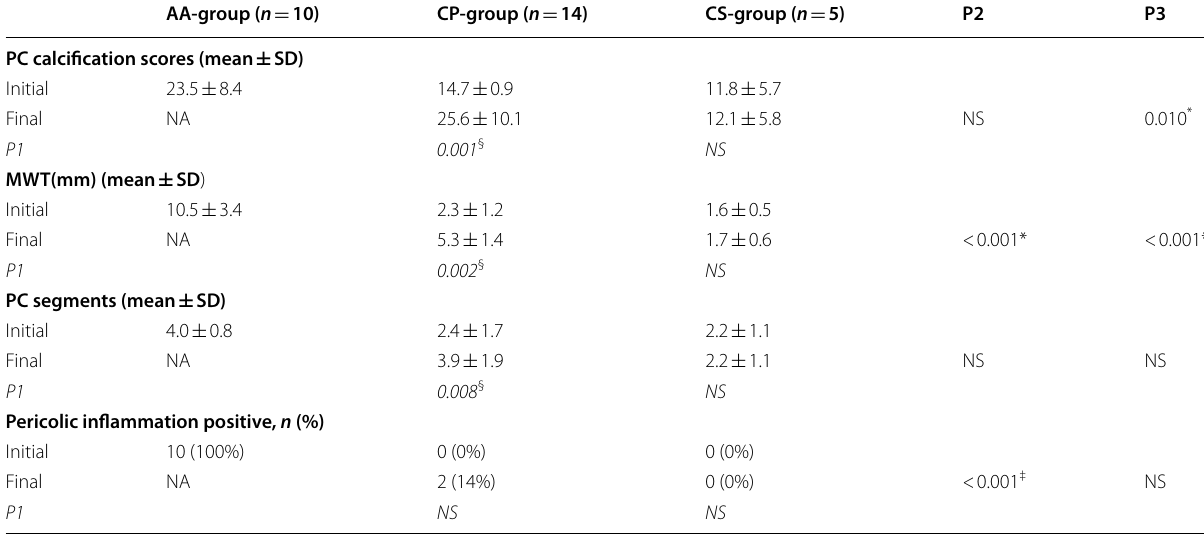
PC, phlebosclerotic colitis; MWT, maximum colonic wall thickness; initial, initial CT; final, final follow-up CT, NA, not applicable for post-operative CT follow-up of AA-group; NS, not